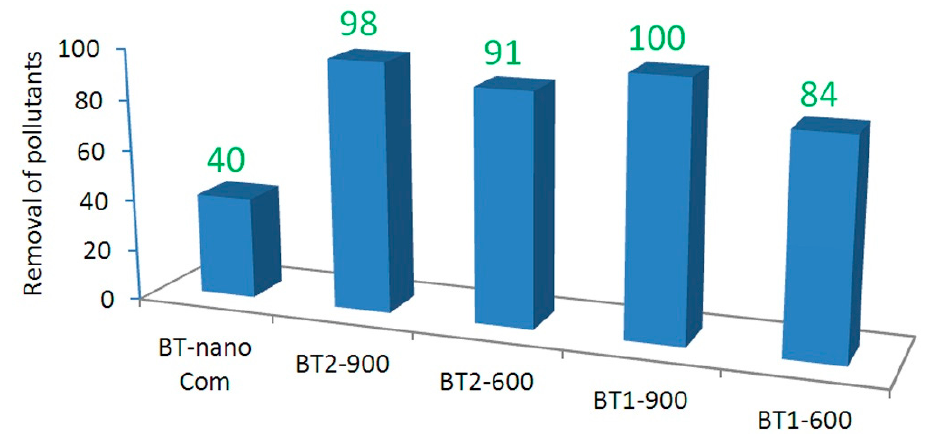
Figure 14. Percentage removal of naphthol green B after reacting for 10 min in sunlight.